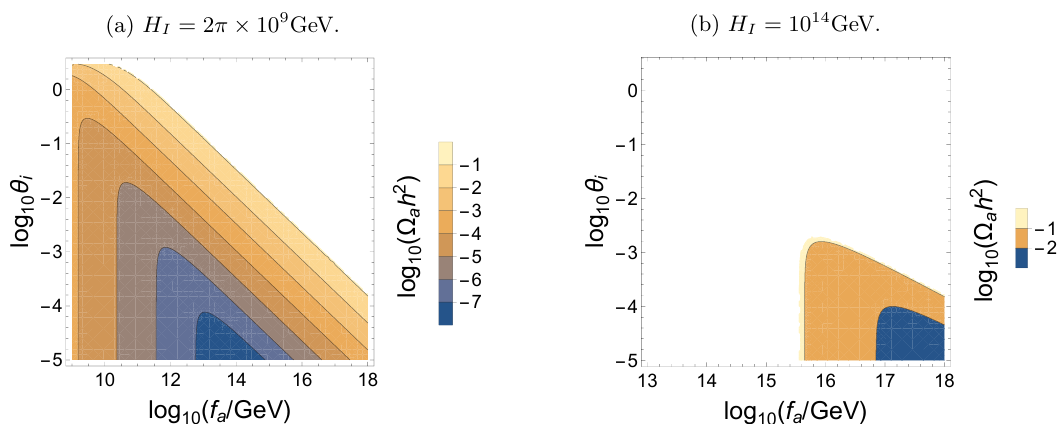
Figure 2. Relic density of QCD axion dark matter produced through misalignment in PQ broken scenario, and f 10 18 GeV. The region shows axion relic density when it does not excess the a < overall cold dark matter (CDM) density Ω 2 = 0 . 12 . The left figure is for a inflationary scale d h H I = 2 π × 10 9 GeV. While the right one is for H I = 10 14 GeV, when only fine-tuning θ i is allowed due to abundance constrain. Reproduced from [83].